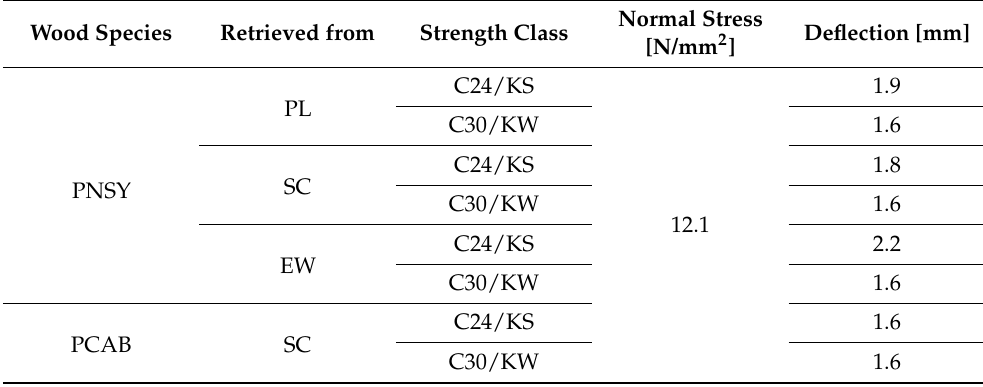
Table 8. Normal stresses and deflection (displacement) of D version short frames made of solid wood material.